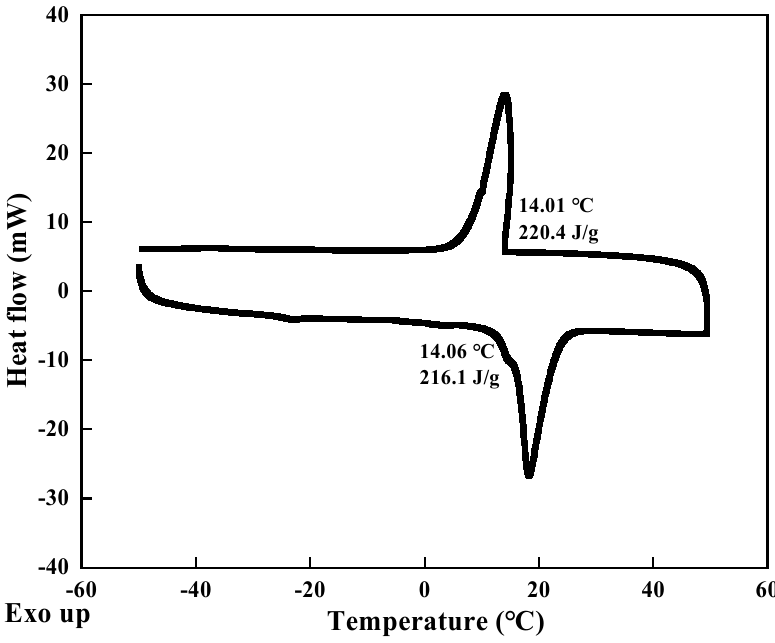
Figure 3. DSC spectra of prepared modified n-alkane. Table 1. Latent heat properties of the microcapsules under different